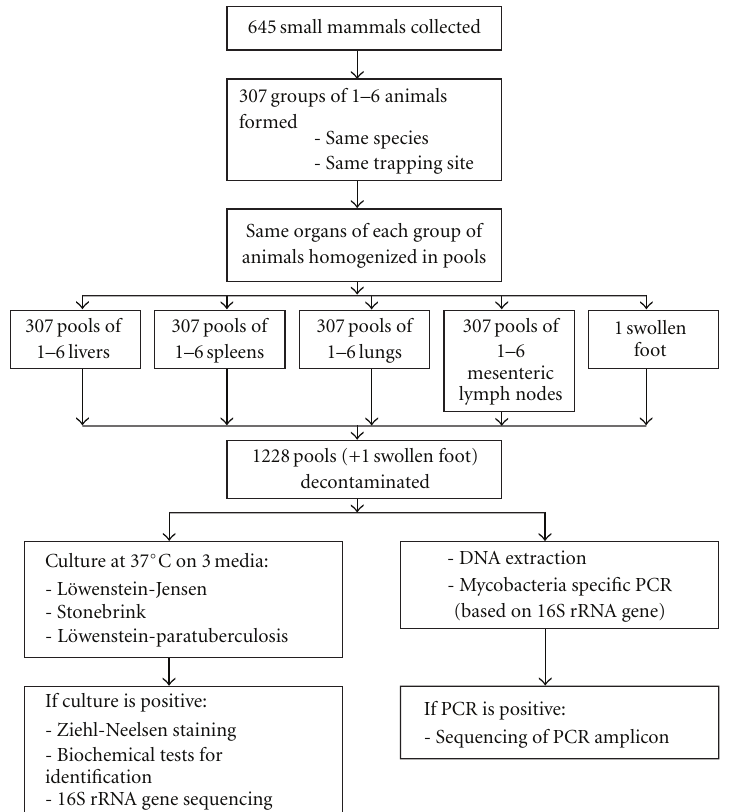
Figure 1: Flow chart of pooling